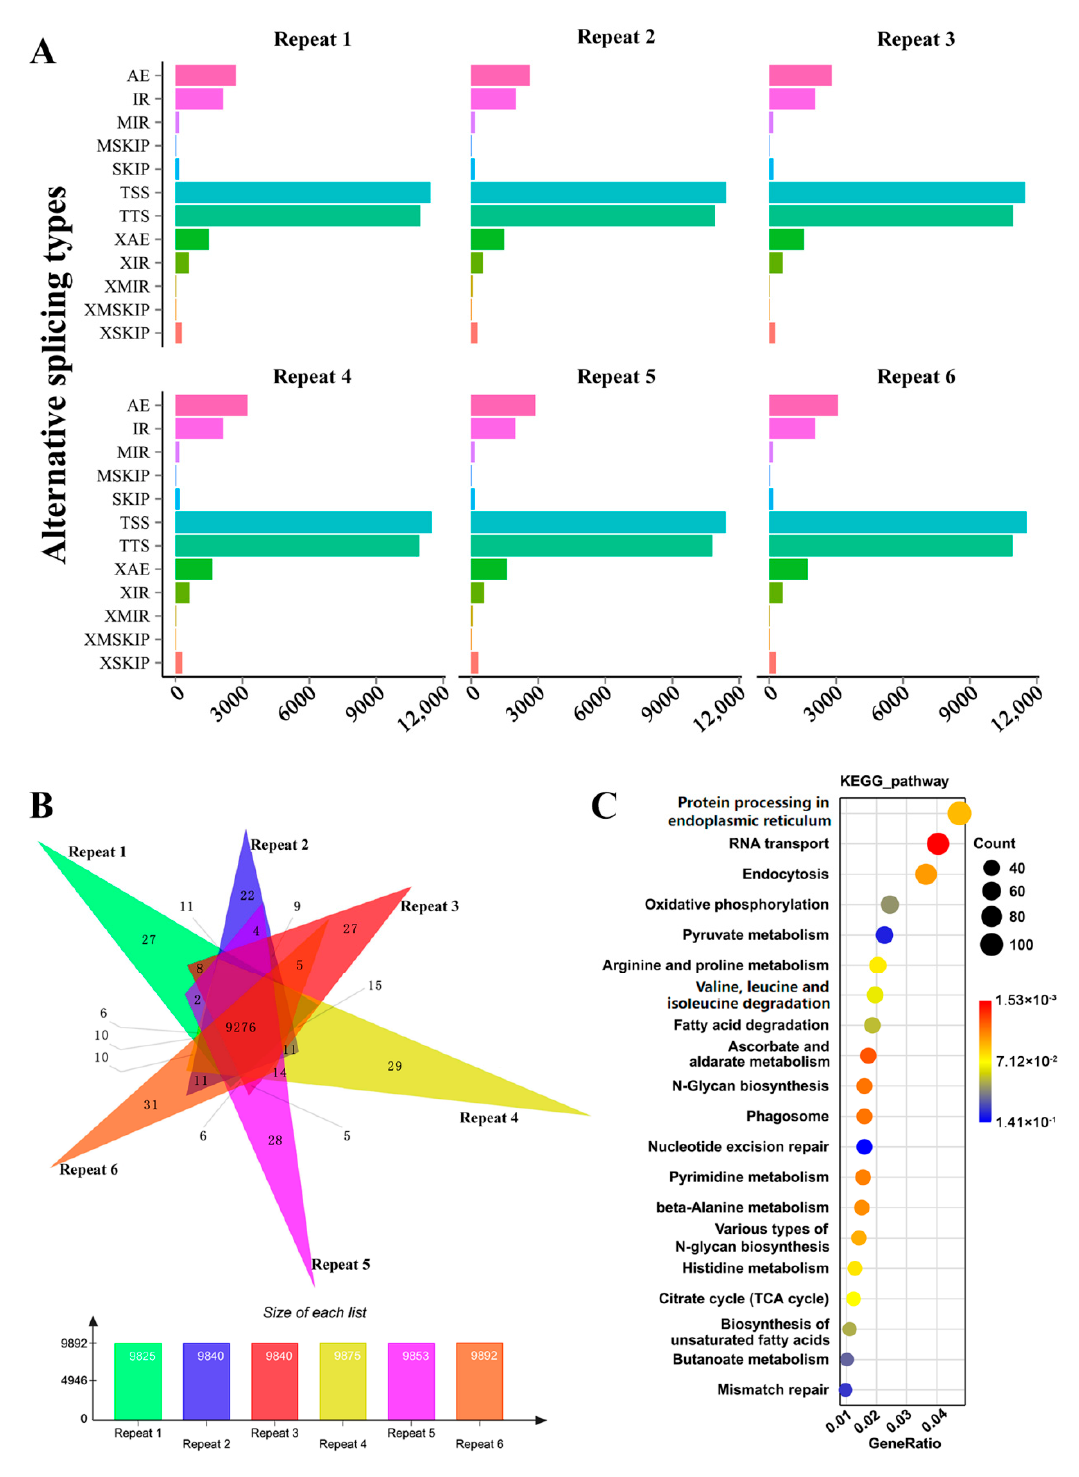
Figure 6. Alternative splicing analysis. ( A ) Statistics of alternative splicing events. X -axis: Number